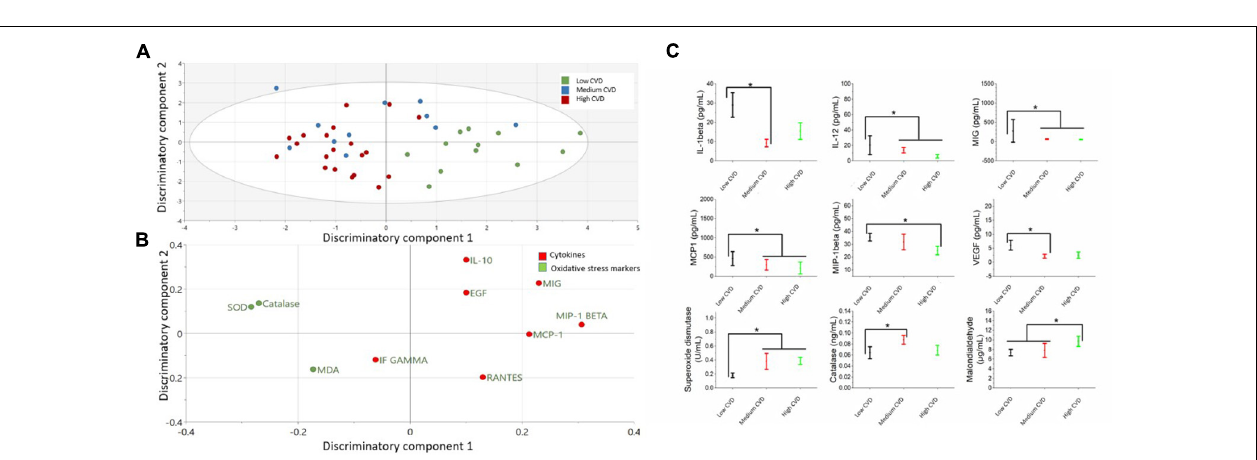
FIGURE 2 | Differences in cytokines and oxidative stress markers among cardiovascular demand (CD) rank groups (low, moderate and high). (A) The score plot of OPLS-DA model comparing analytes from three power groups, exhibits class-discriminatory component 1 ( x -axis) versus class-discriminatory component 2 ( y -axis). (B) The corresponding loading plots showing top associated analytes differentiating low, moderate and high CD groups. (C) Significant differences in cytokines and oxidative stress markers among the three groups by KS test (* p <